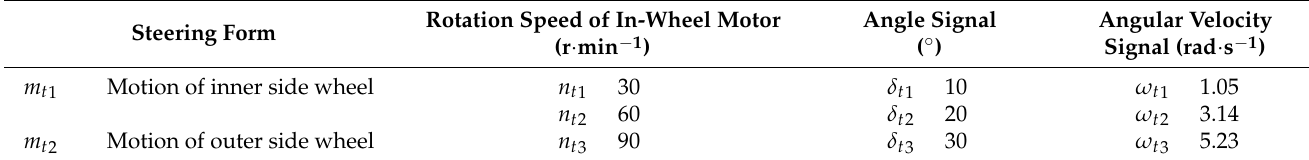
Table 1. List of test cases.